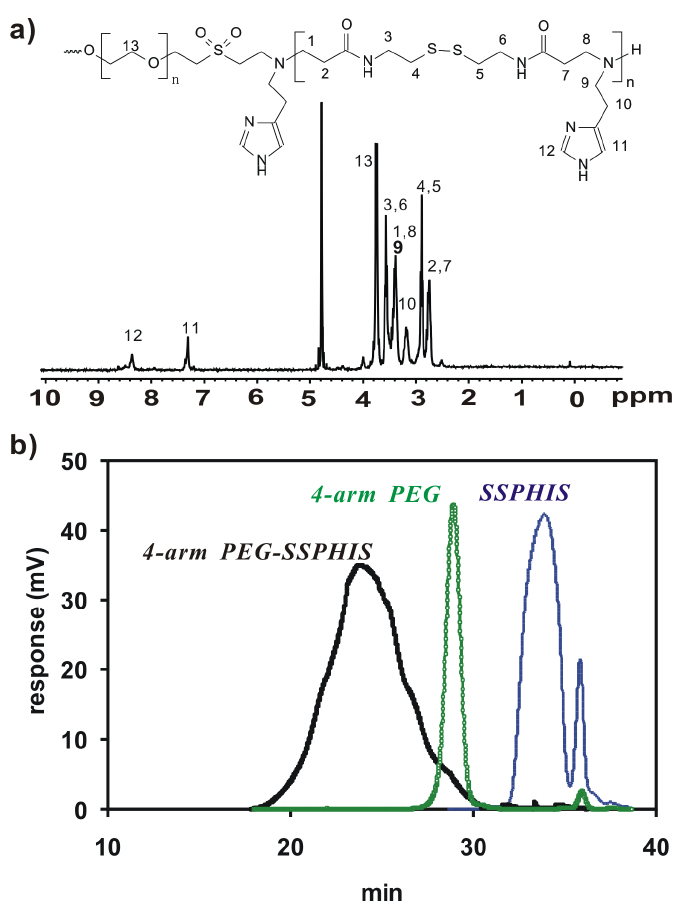
Figure 2. ( a ) 1 H NMR spectra (D O, 300 MHz) of 4-arm PEG-SSPHIS; ( b ) GPC 2 chromatogram of 4-arm PEG-SSPHIS, 4-arm PEG and SSPHIS